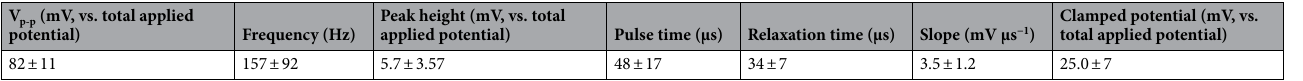
Table 1. Curve fitting (modeling) of the electrical VLF signals related to the AP perturbations. The data are the average of 15 independent analyses ± : Standard deviation.